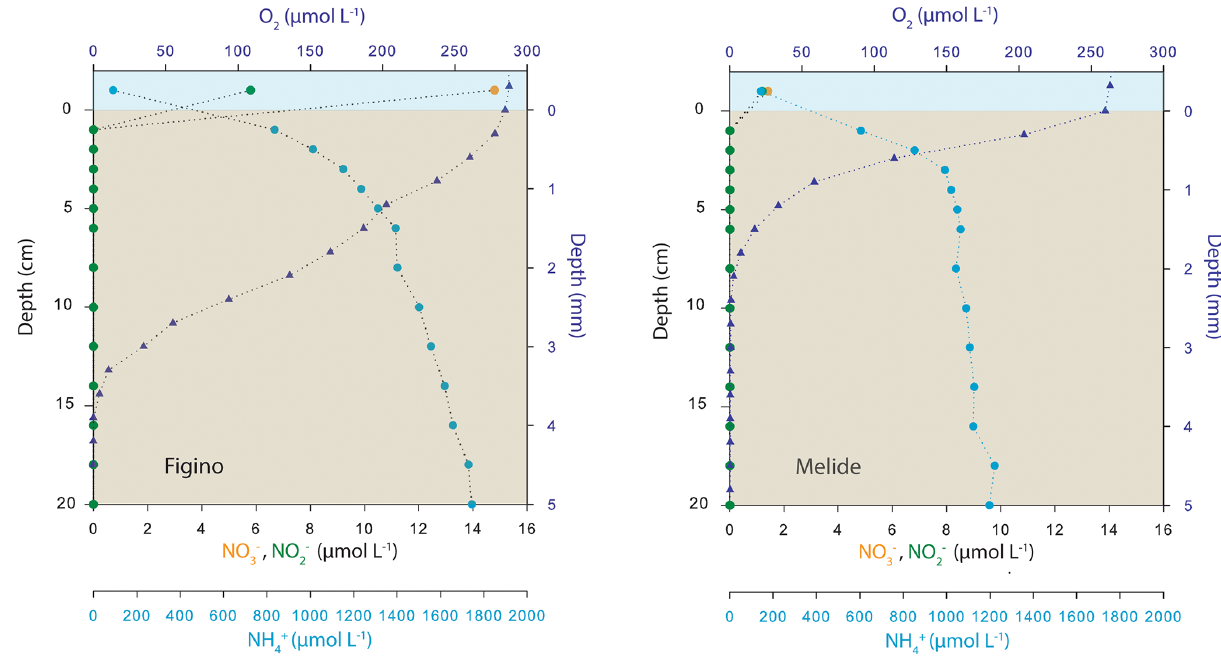
Figure 2. Ex situ sediment porewater profiles (O 2 and dissolved inorganic nitrogen) at the two sampling stations of the Lake Lugano south basin in sediment cores collected in October 2017. Symbols correspond to the mean value of O 2 (triangles) and dissolved N species (circles) concentrations measured in triplicate and duplicate cores, respectively. Oxygen concentration profiles (note different depth units) were determined in aerated cores and thus are representative of the O 2 penetration during aerated conditions in the water column, as seen between January and April (see Fig.